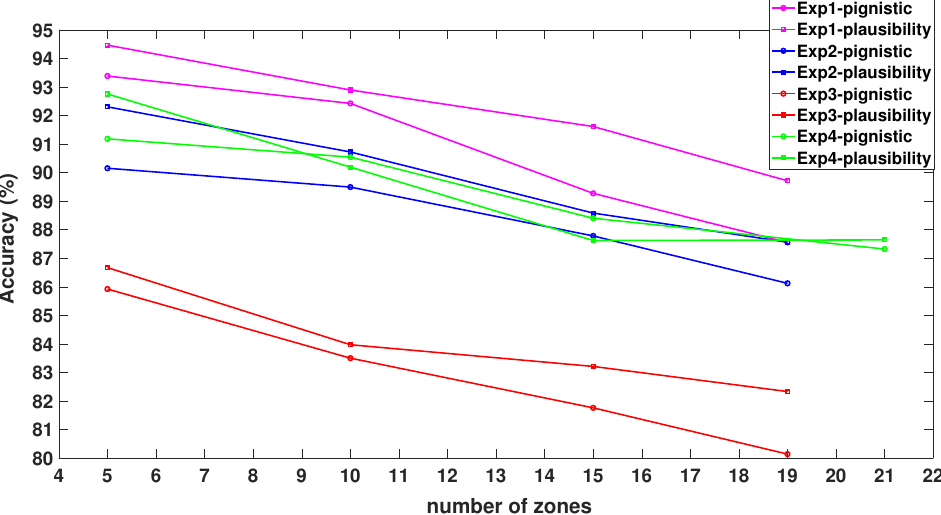
Figure 5. Influence of the number of zones and decision-making on the overall accuracy